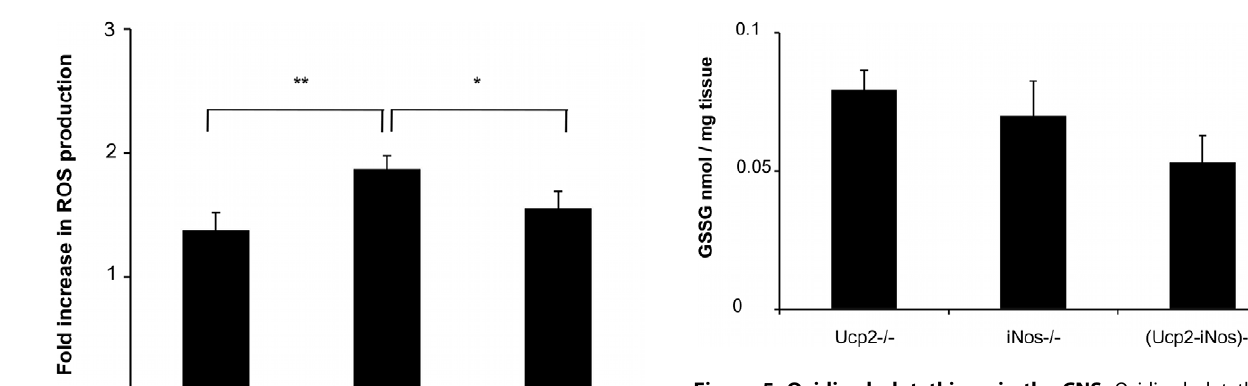
Figure 5. Oxidized glutathione in the CNS. Oxidized glutathione was assayed 14 days after EAE induction, as described in experimental procedures, in the CNS from Ucp2 2 / 2 , iNos 2 / 2 and (Ucp2-iNos) 2 / 2 deficient mice. Data represents means 6 SEM of 4–5 mice per genotype.